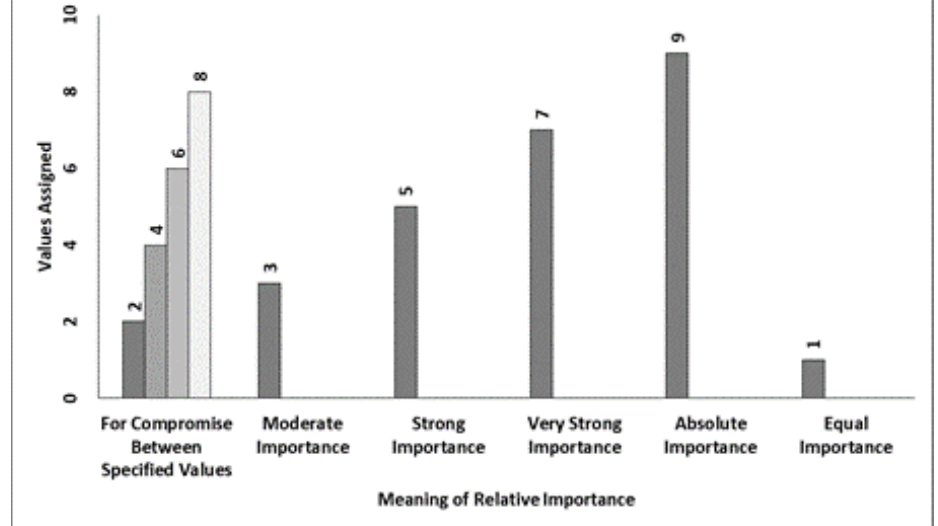
Figure 9. Relative importance